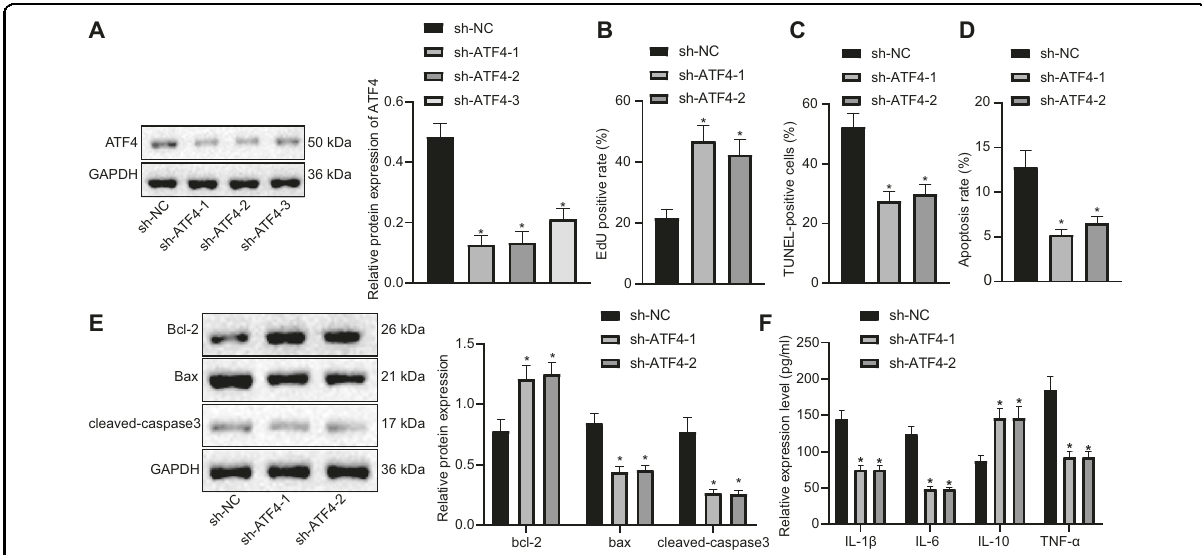
Fig. 2 Downregulation of ATF4 promotes pancreatic acinar cell proliferation and inhibits apoptosis. A Western blot analysis was performed to detect ATF4 silencing ef fi ciency. B EdU was applied to detect pancreatic acinar cell proliferation after sh-ATF4-1 or sh-ATF4-2 treatment. C TUNEL was performed to detect pancreatic acinar cell apoptosis after sh-ATF4-1 or sh-ATF4-2 treatment. D Flow cytometry was performed to detect pancreatic acinar cell apoptosis after sh-ATF4-1 or sh-ATF4-2 treatment. E Western blot analysis was performed to detect expression of Bcl-2, Bax and cleaved-caspase3. F ELISA was conducted to test levels of IL-1 β , IL-6, TNF- α , and IL-10. * p < 0.05 compared with the sh-NC group. The comparison of the measurement data (mean standard ± deviation) among multiple groups was analyzed by one-way analysis of variance with Tukey ’ s post hoc